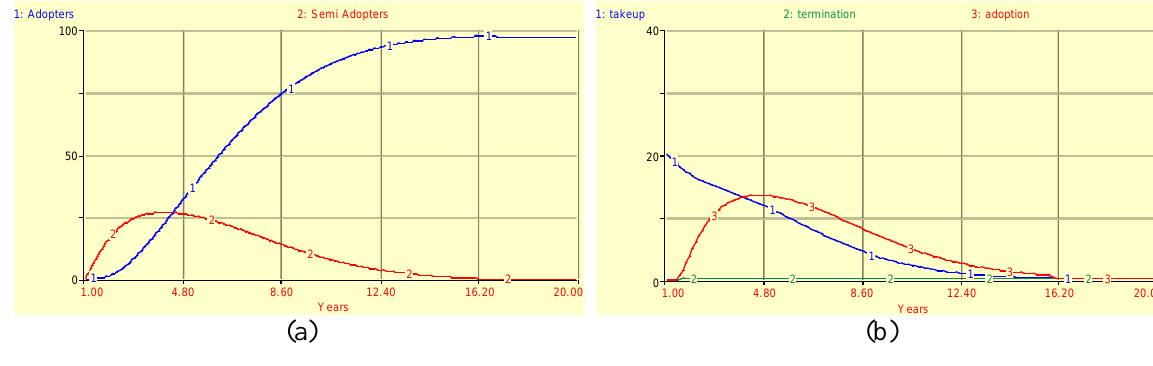
Fig. 3. Basic simulated behaviour of RET